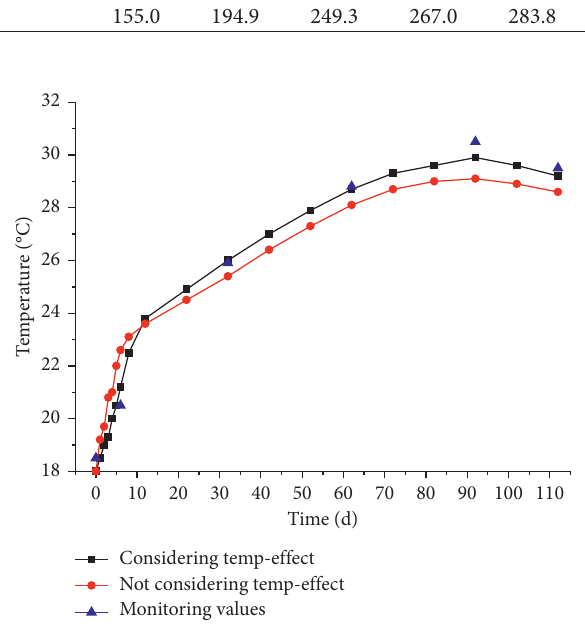
Figure 3: Temperature history curve of position T